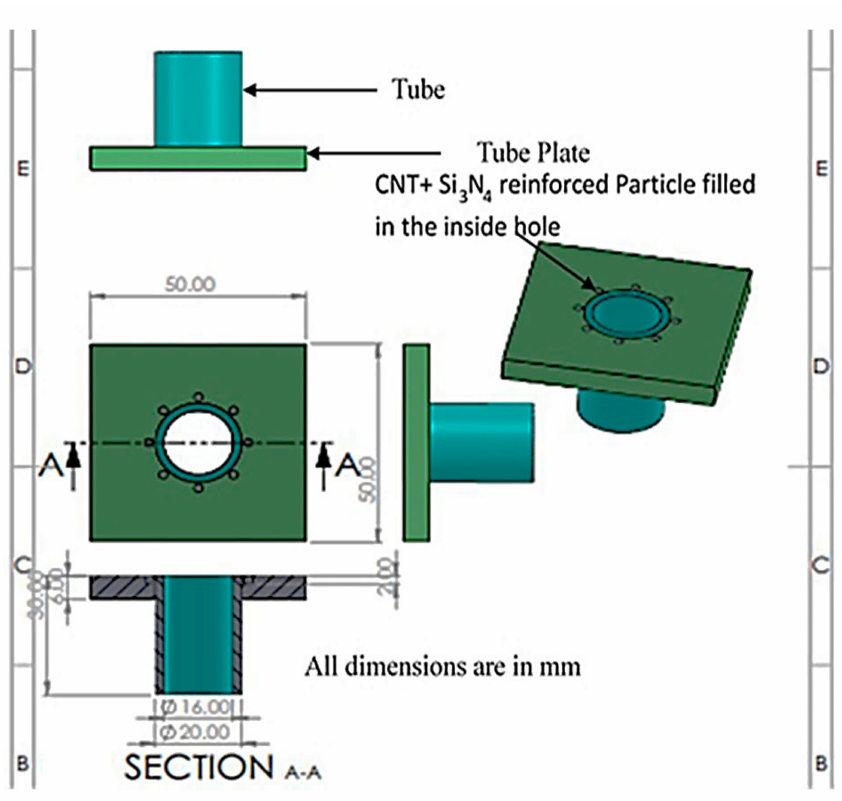
Figure 2. The actual dimensions of the tube and tube plate specimens for implementing the FWTPET + FSP